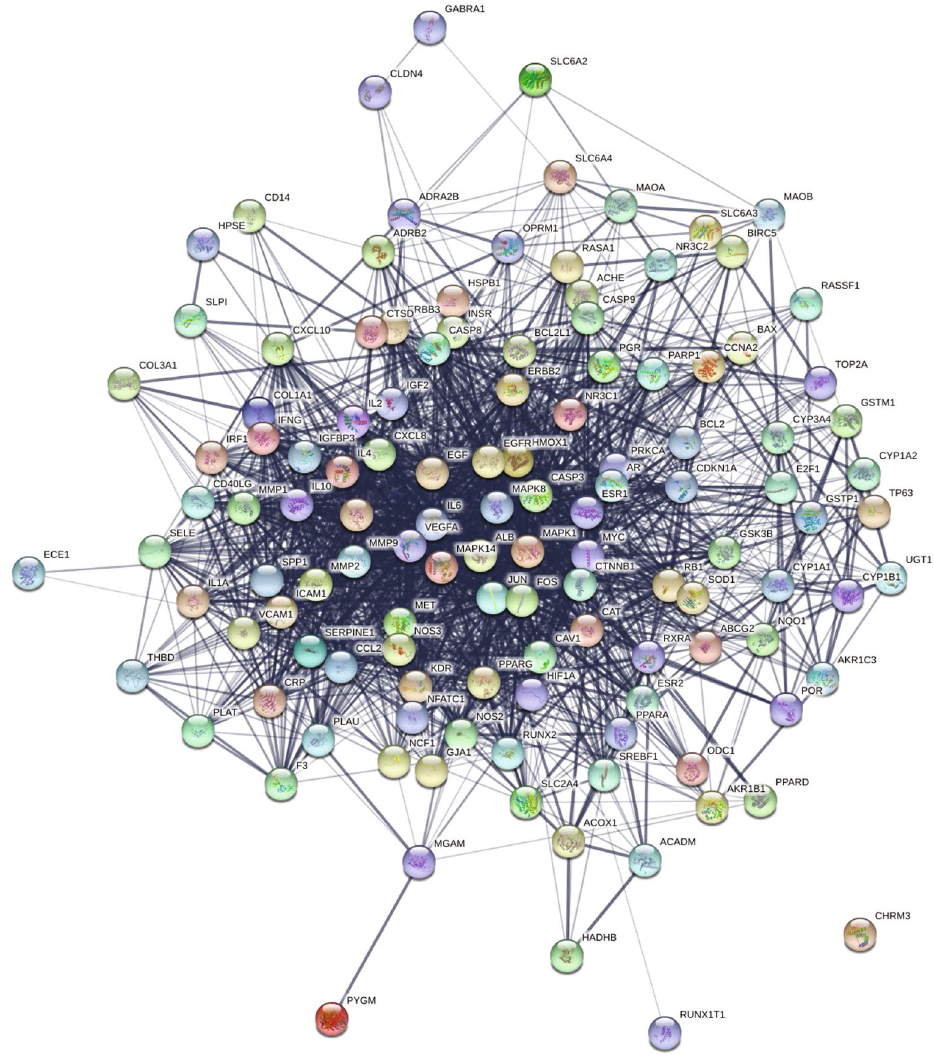
Figure 4: Protein-protein interaction network. 122 nodes (target genes) and 1944 edges (associations between proteins) are